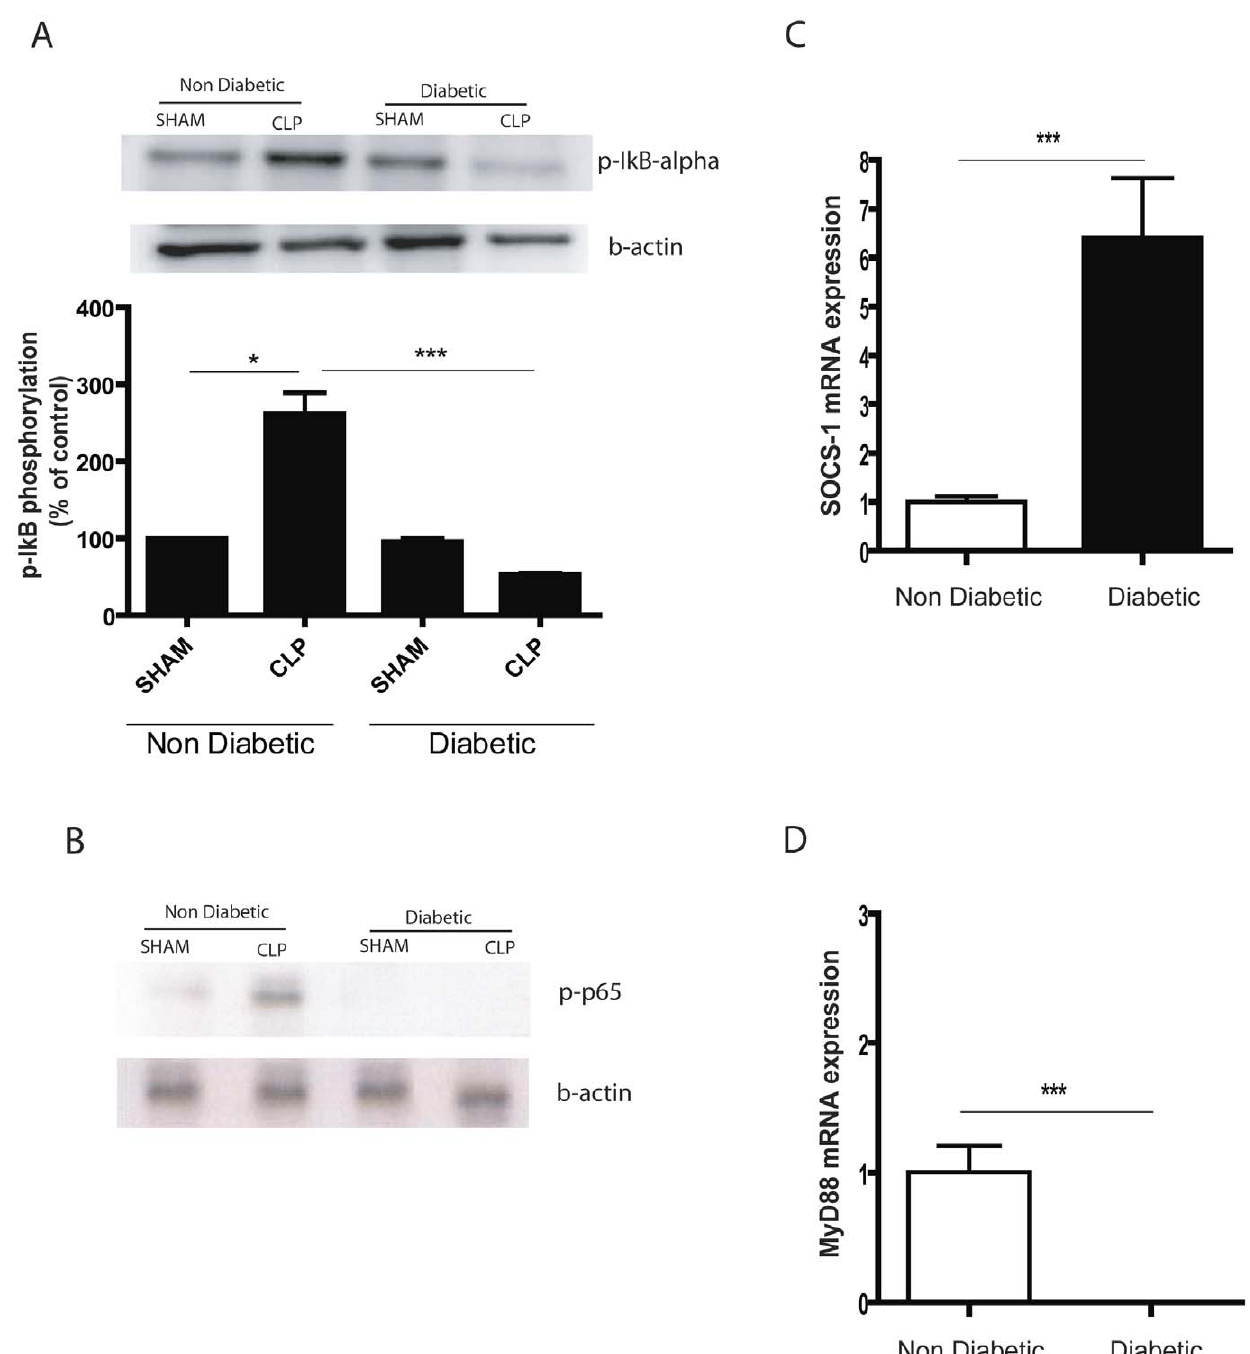
Figure 5. NFkB activation in alveolar macrophages 6h after CLP. Alveolar macrophages ( AM) were obtained by lung lavage six hours after CLP and allowed to adhere in culture plates for 1 h. Total mRNA or total protein was extracted from AMs. ( A ) 20 m g of total protein analysed by immunoblotting using antibodies to phosphorylated – I k B a and b -actin.The bands were quantified by densitometric analysis. Density values of bands were normalized to the total b -actin present in each lane and expressed as percentage of control. ( B ) 50 m g of total protein analysed by immunoblotting using antibodies to phosphorylated – p65 and b -actin. ( C ) cDNA was synthesized from total mRNA extracted and the expression of SOCS-1. ( D ) MyD88 mRNA was analysed by RT-PCR. mRNA expression levels were calculated by the comparative Ct method and normalized to GAPDH levels with non-diabetic CLP given an arbitrary value of one. n=5/group, data were presented as mean 6 SEM.* P , 0.05; ***, P , 0.001. doi:10.1371/journal.pone.0044987.g005 The finding that reduced inflammation in diabetics with sepsis is unveils a novel mechanism that helps to explain the molecular related to impaired activation of NF-kB in alveolar macrophages basis for the lung ‘protection’ observed in diabetics with sepsis.